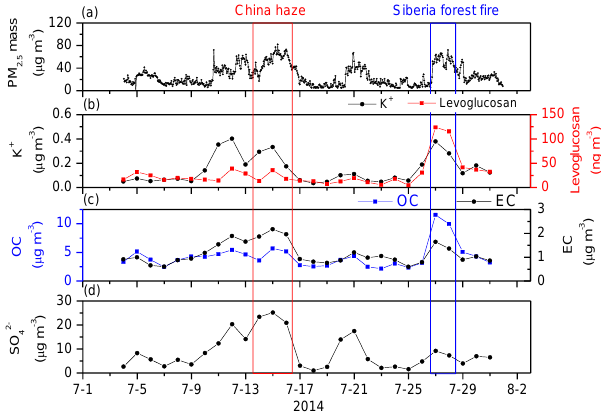
Figure 9. Temporal variations in PM 2 . 5 mass, K + , levoglucosan, OC, EC, and SO 2 − concentrations at the Daejeon site over the entire 4 measurement